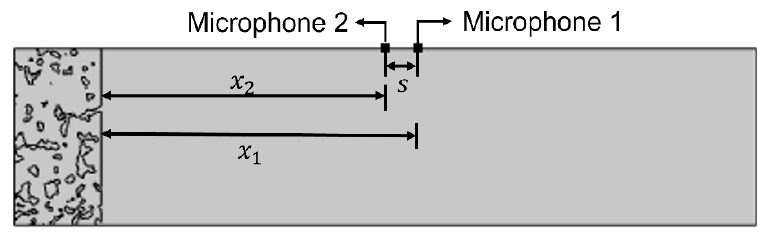
Figure 10. Model of the impedance tube. 𝑥 1 : the distance of microphone 1 from the reference surface, 𝑥 2 : the distance of microphone 2 from the reference surface.